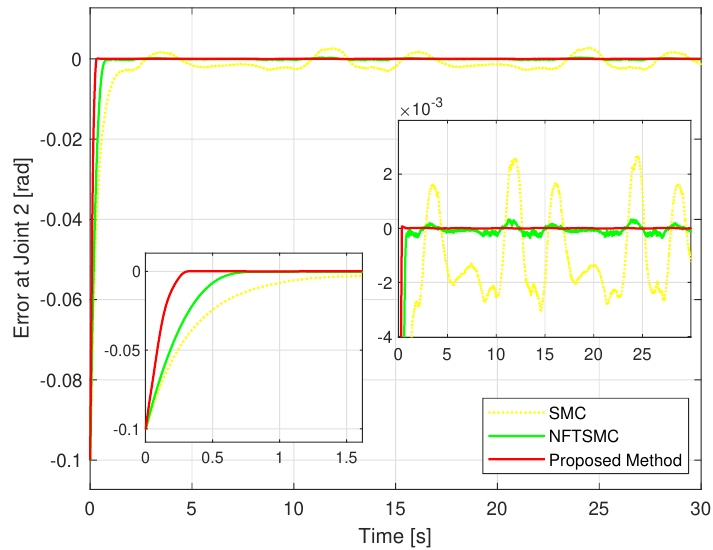
Figure 8. The TCE comparison between the position of the second joint and the desired path.